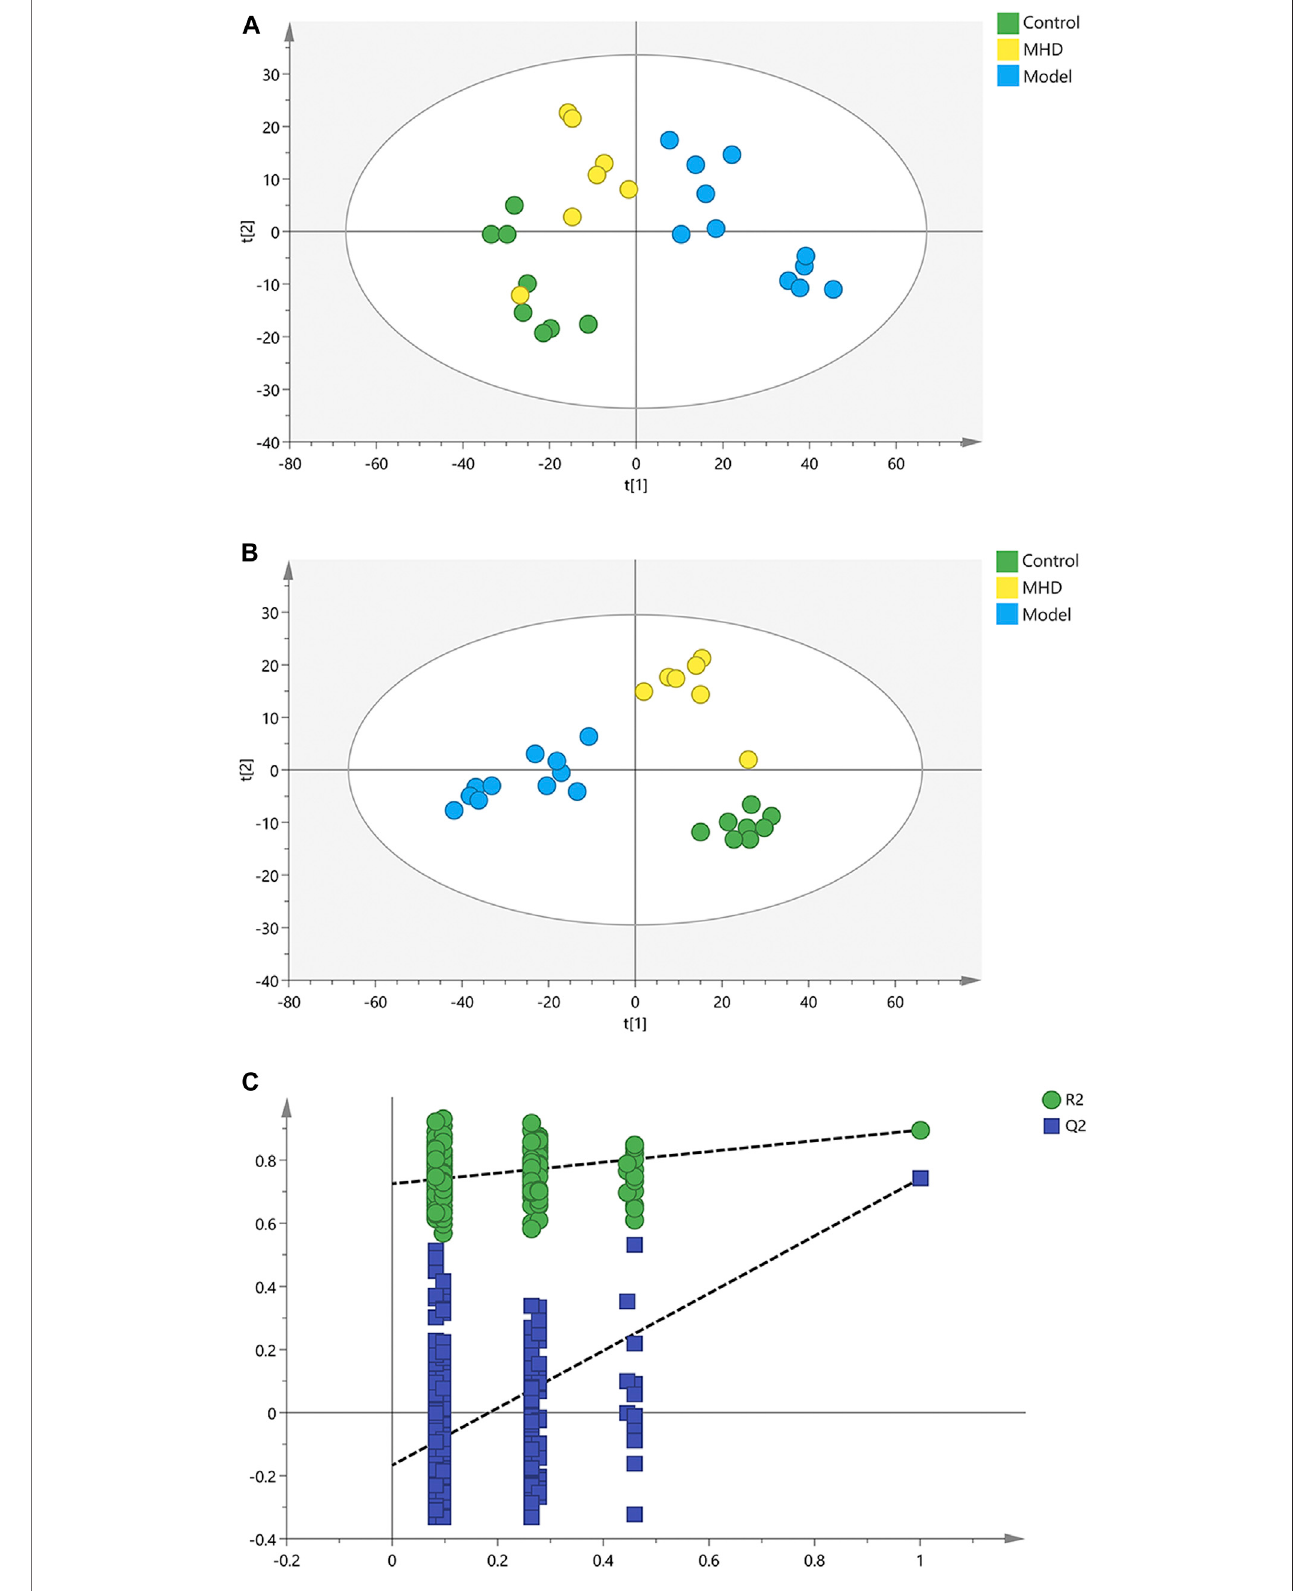
FIGURE 2| PCA, PLS-DA and permutation test ofserum samples. (A) PCA score scatter plots. (B) PLS-DA score scatter plots. (C) Permutation tests of PLS-DA.